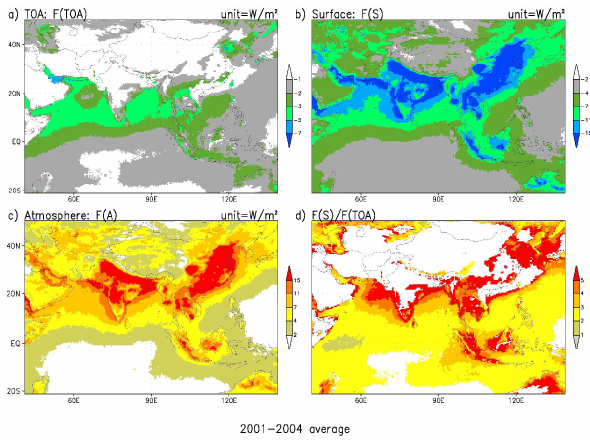
Figure 8. Anthropogenic direct aerosol radiative forcing averaged over the entire 2001–2004 period. In this and subsequent figures, the forcing estimates are for cloudy skies.